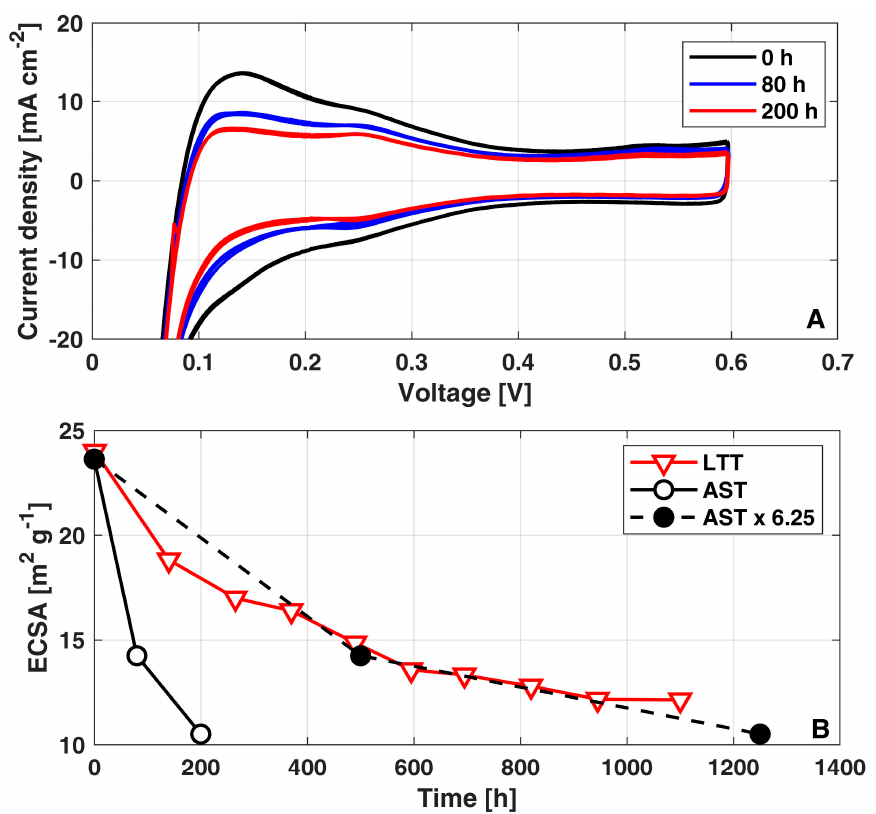
Figure 4. ( A ) Voltammograms measured during the AST; ( B ) Evolution of cathode ECSA loss during AST, AST multiplied by acceleration factor of 6.25x and LTT. The data of LTT have been already reported in [10]. Figure 4B quanti fi es the corresponding cathode ECSA values (solid black curve): a